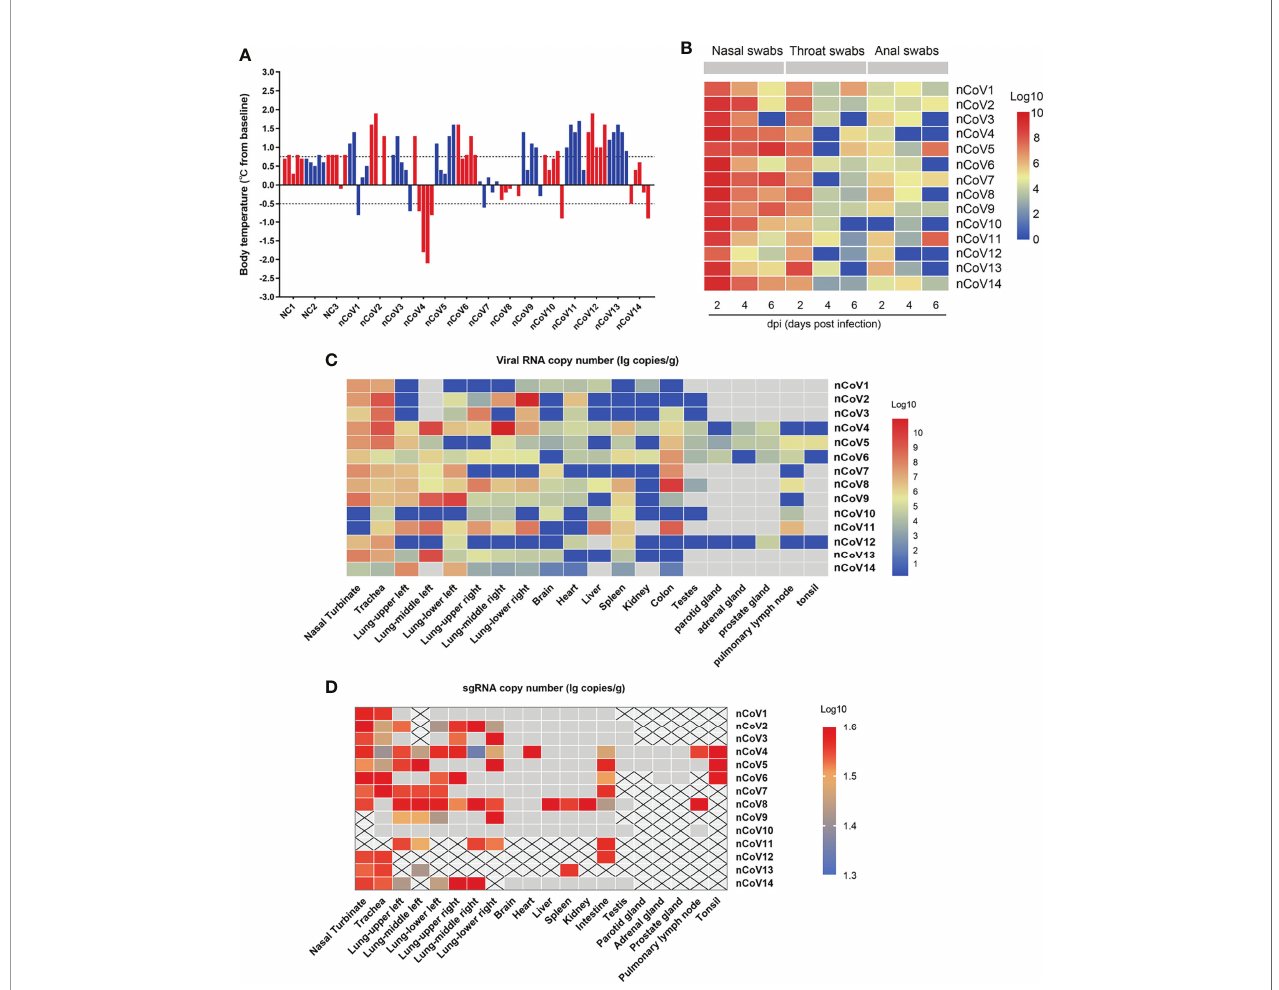
FIGURE 2 | Body temperature, viral shedding and replication in CMs inoculated with SARS-CoV-2. (A) The body temperature of each monkey was monitored and recorded at above indicated time points after SARS-CoV-2 inoculation (0, 2, 4, 6, 7dpi). The body temperature changes were calculated by subtracting the baseline (37°C) from each. (B) Every two days after virus inoculation, swabs (nasal, throat, and anal) were collected from the monkeys for quanti fi cation of virus genomic RNA via qRT-PCR. (C) Tissue samples were harvested from necropsied animals at 7 dpi for detection of viral load by qRT-PCR. The viral copies were indicated as a log 10 value, and the heatmap was prepared via heatmap illustrator in TB tools. (D) E gene subgenomic viral RNA transcripts were examined by qRT-PCR. qRT-PCR, real- time quantitative-polymerase chain reaction; sgRNA, subgenomic